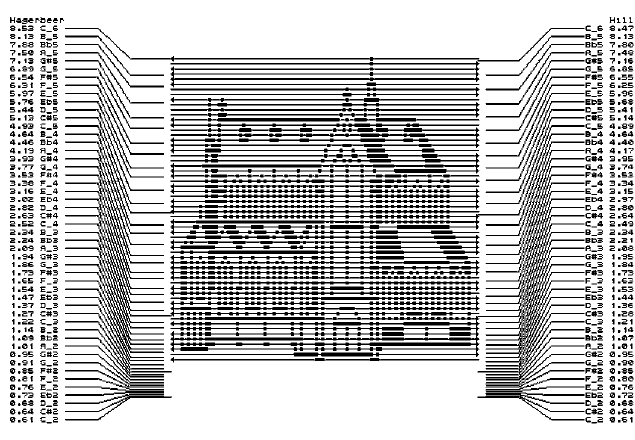
Figure 16: Pitch derivation from an image of St. Peter’s Church in Bark and 12-tone-tempered